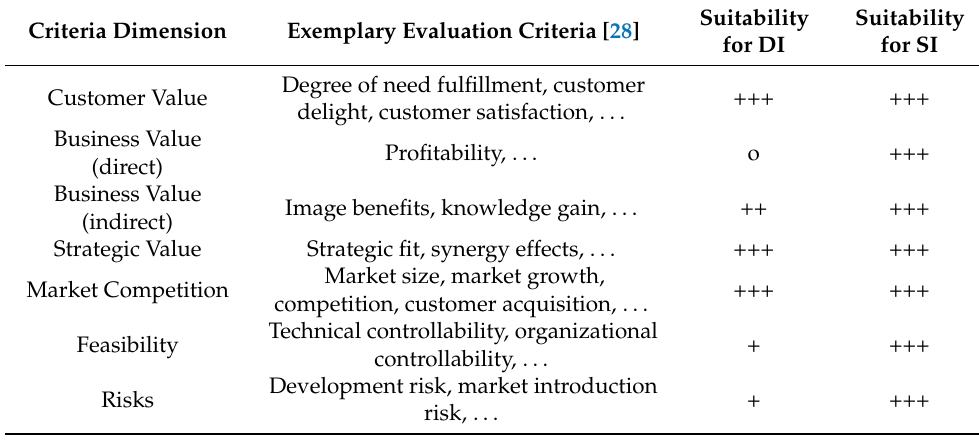
Table 4. Suitability of evaluation criteria for idea